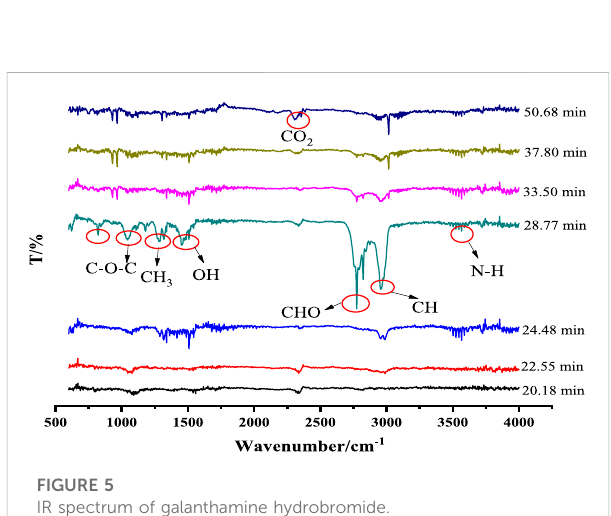
FIGURE 5 IR spectrum of galanthamine